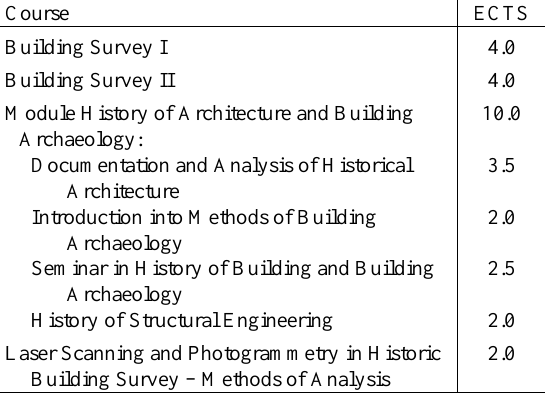
Table 1. Survey Courses at the Department of History